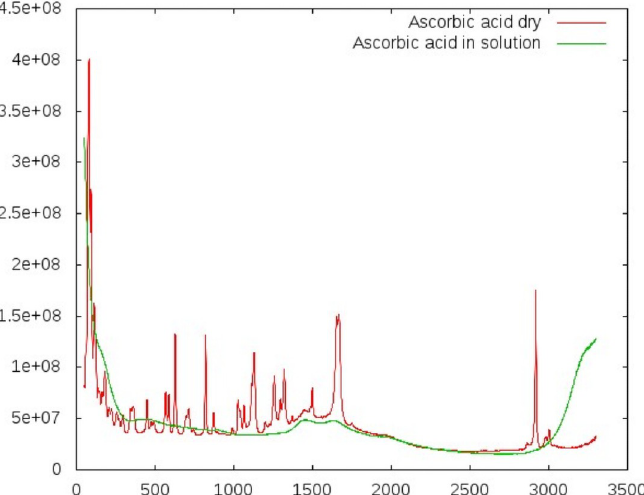
Fig 1. Comparing dry samples and samples in solution: Ascorbic acid. All specific peaks vanish in solution for these substances. At around 1500 cm − 1 , the fluorescence background of the glass carrier is visible. Exposure time: 172 s, concentration: 10 mmol/l.